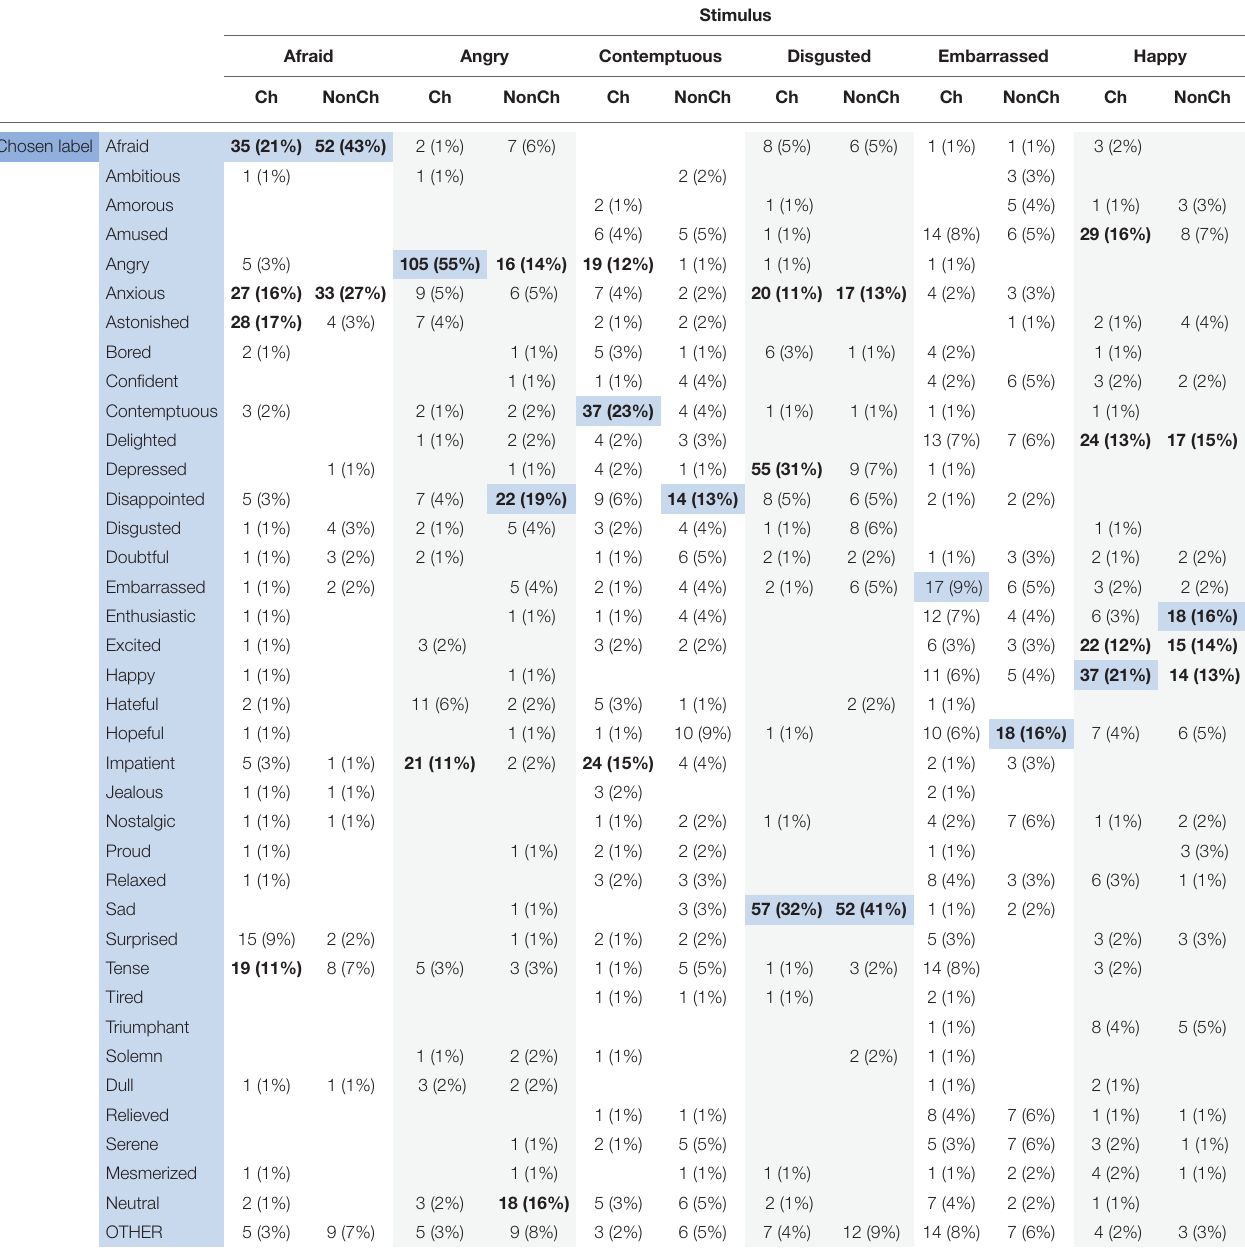
TABLE 3.1 | Frequencies of the label chosen to describe the emotion perceived in each stimulus, with the highest frequency highlighted in blue, frequencies of 10% or more printed in bold, and frequencies of 2% or less printed in gray for ease of reading (105 < n < 313). Stimulus Afraid Angry Contemptuous Disgusted Embarrassed Happy Ch NonCh Ch NonCh Ch NonCh Ch NonCh Ch NonCh Ch NonCh Chosen label